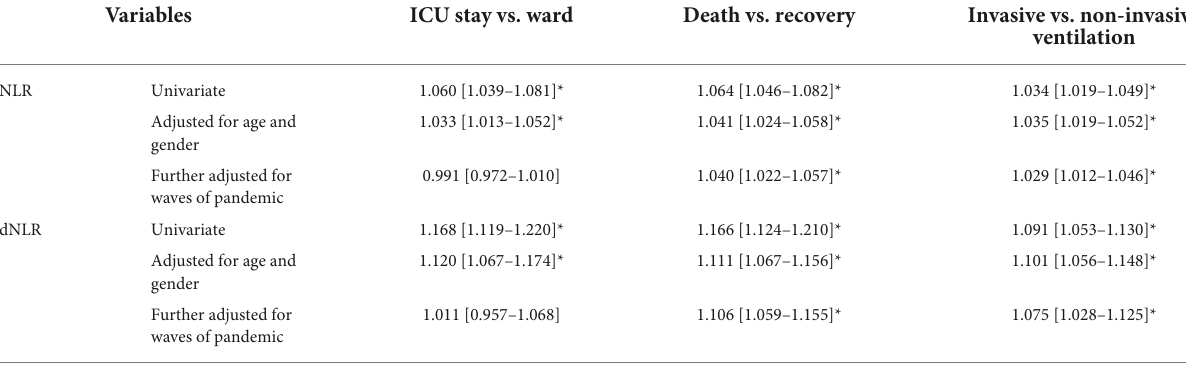
TABLE 2 Binary logistic regression of neutrophil to lymphocyte ratio (NLR) and derived NLR (dNLR) as continuous variables with the study outcomes. Variables ICU stay vs.